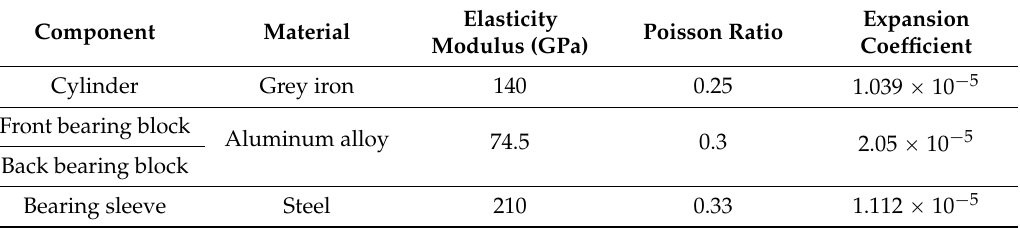
Table 3. Material property of the components of crankshaft bearing support